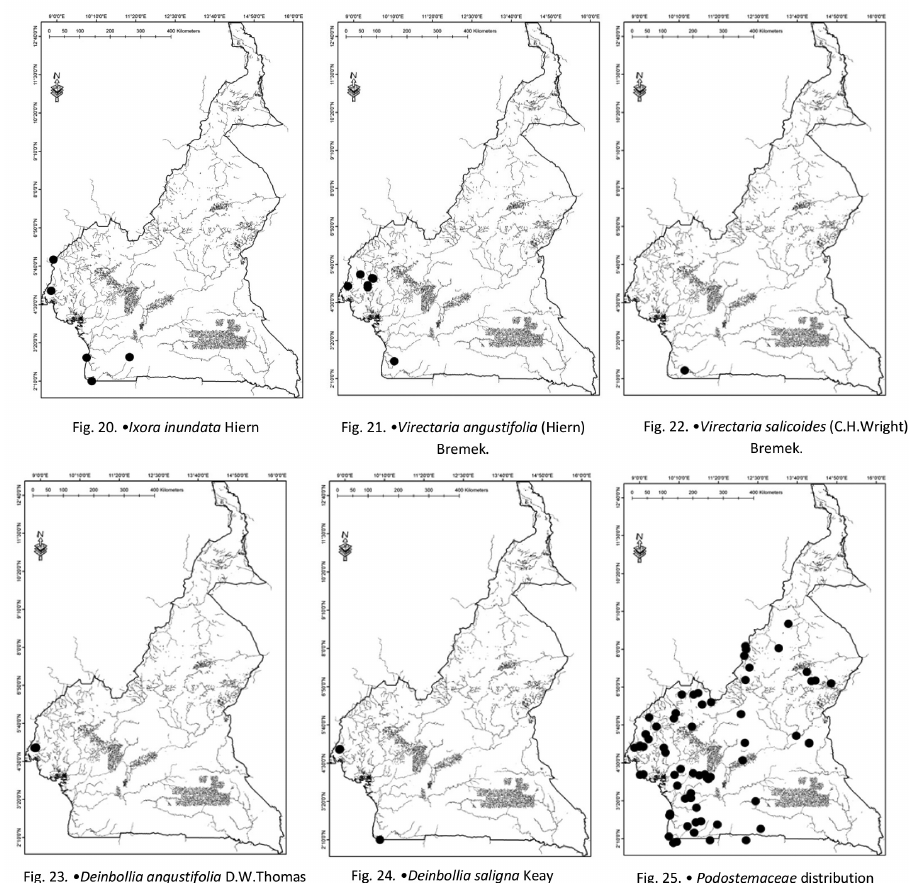
(C.H.Wright) Bremek 23 Deinbollia angustifolia D.W.Thomas 24 Deinbollia saligna Keay 25 Podoste- maceae